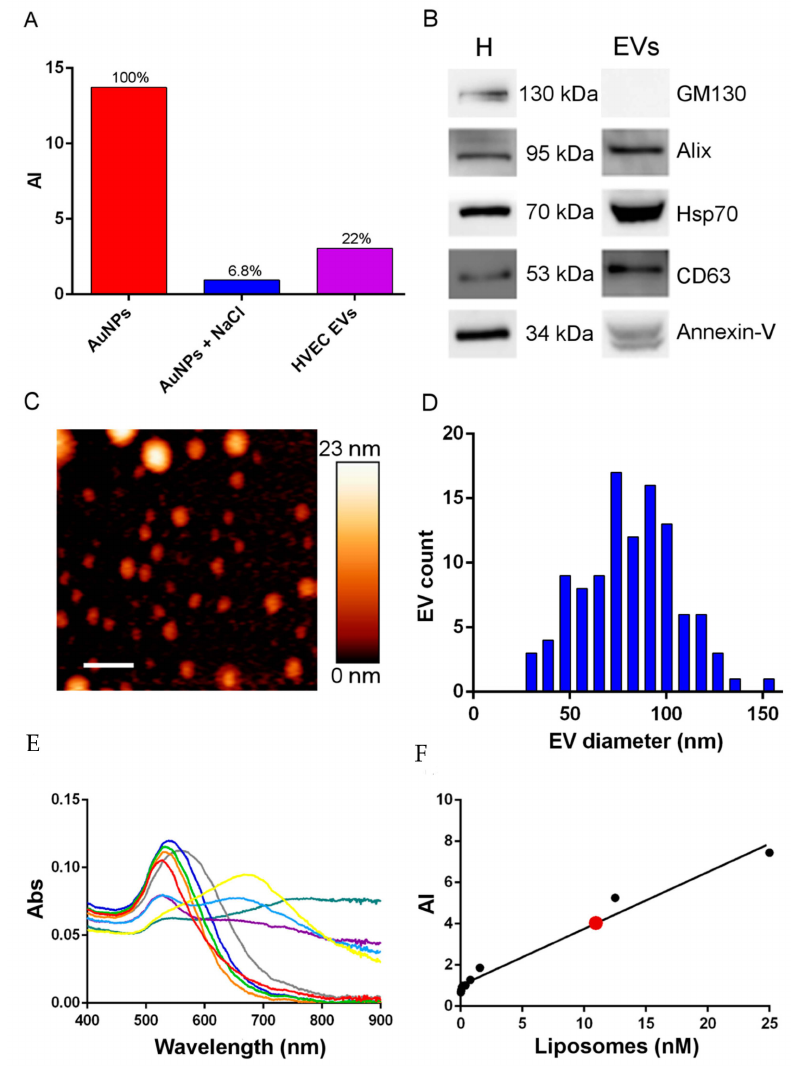
Figure 2. Characterization of extracellular vesicles (EVs) samples. ( A ) Aggregation index (AI) of EV preparation. AI is inversely proportional to the preparation purity grade; ( B ) western blot of EV samples and parent cells (H) with the EV markers Alix, CD63, HSP70, annexin V, and GM130 as negative control; ( C ) Atomic Force Microscopy (AFM) image of EVs (scale bar = 200 nm) and ( D ) EV size distribution. A total of 108 objects with a size between 30 nm and 160 nm were analyzed; ( E , F ) Colorimetric nanoplasmonic (CONAN) analysis of molar concentration of EVs. Refer to the main text for the